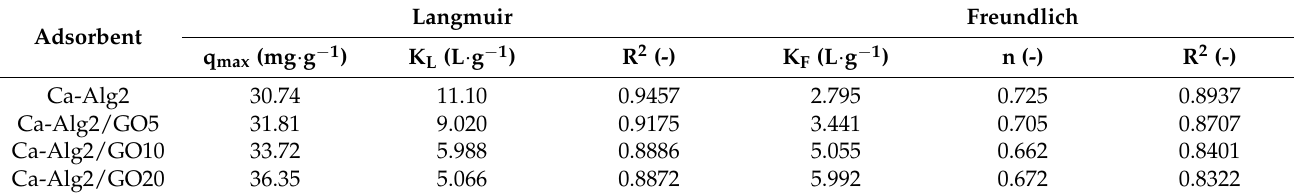
Table 9. Langmuir and Freundlich isotherm constants for DFC adsorption onto Ca-Alg2 and Ca-Alg2/GO beads. Adsorbent